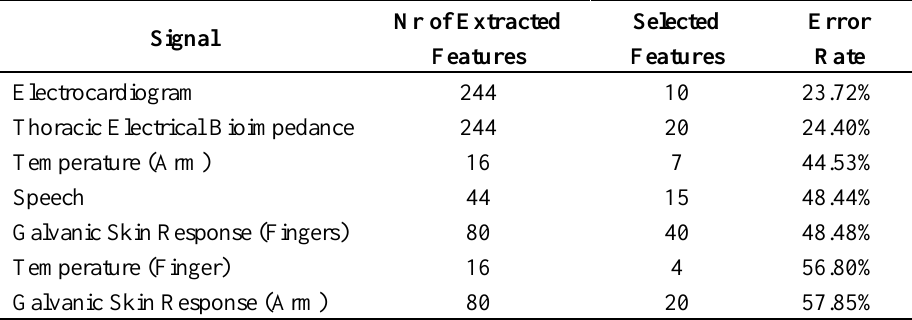
Table 2. Signals recorded on the